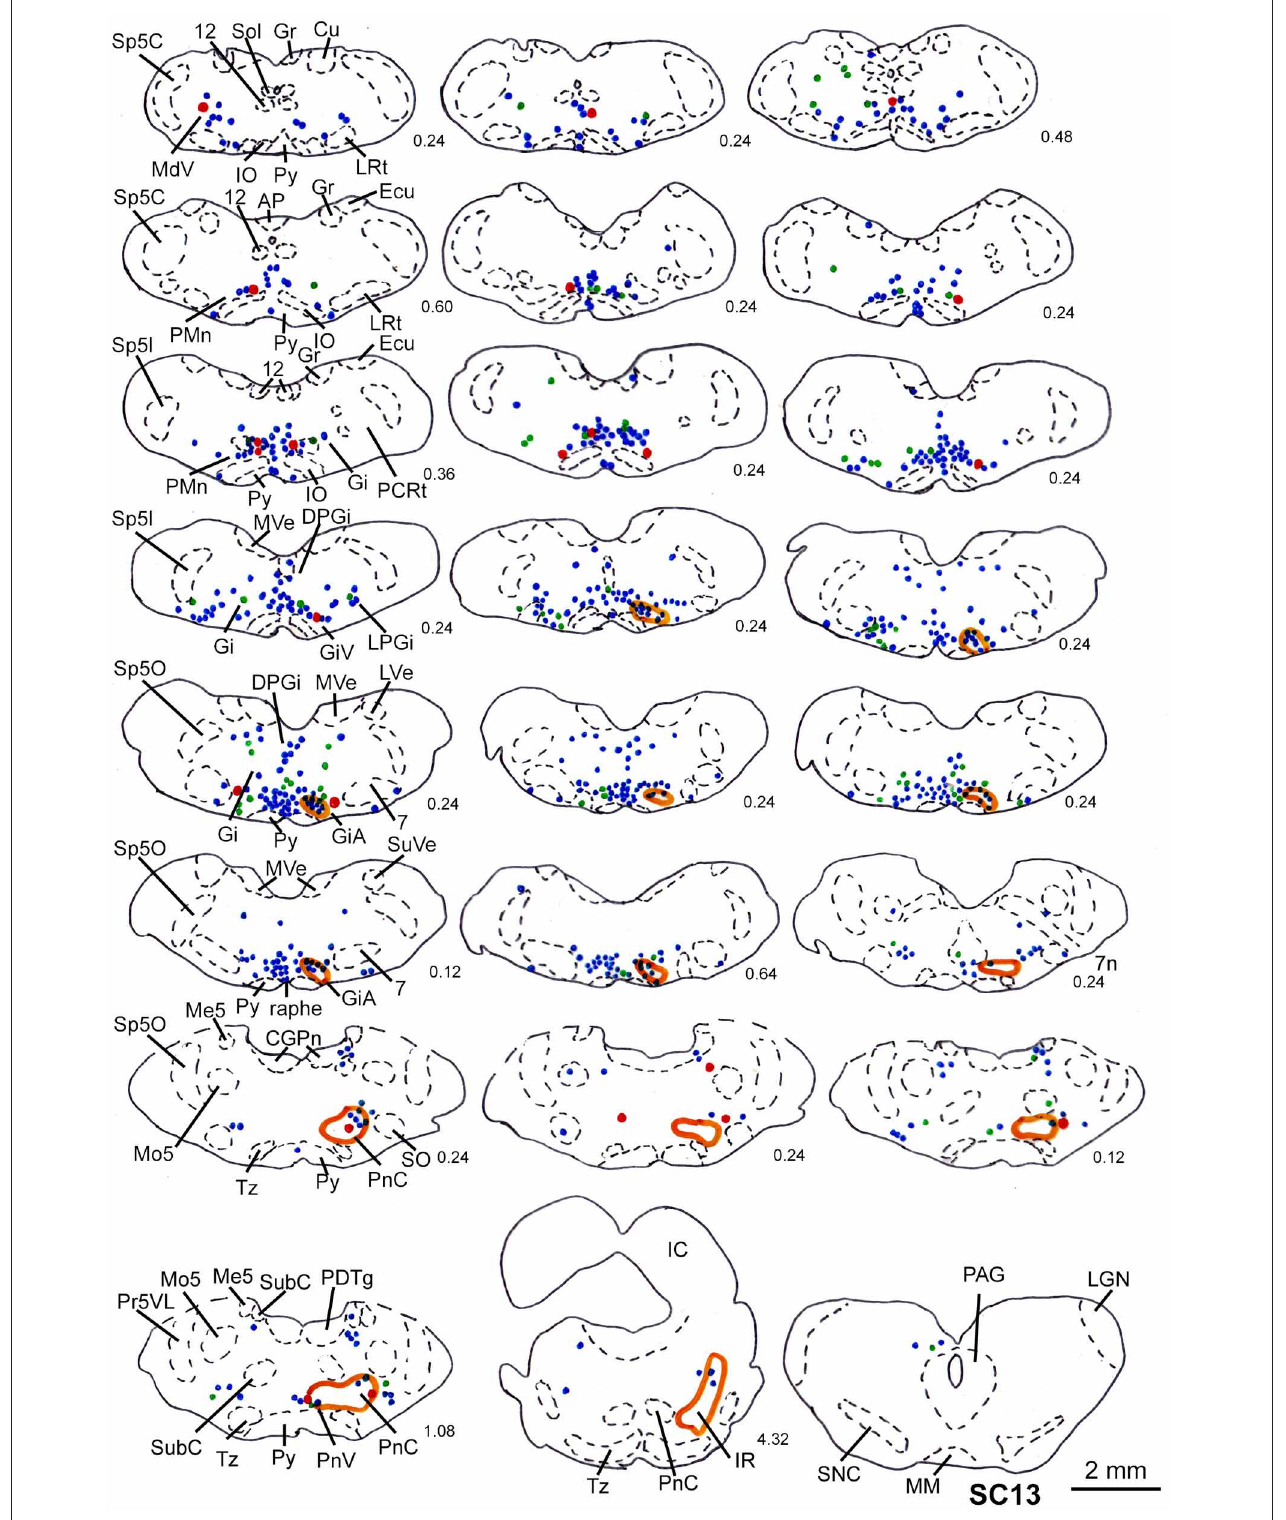
FIGURE 10 | Series of frontal sections through the brainstem and midbrain of case SC13 showing retrogradely labeled neurons after virus injection into the left m. acromiodeltoideus and left m. rhomboideus